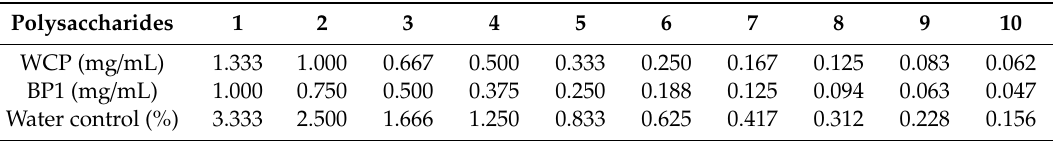
Table 1. Dosing regimen of anti-proliferation assay. Legend: WCP, water-soluble polysaccharides; BP1, base-soluble